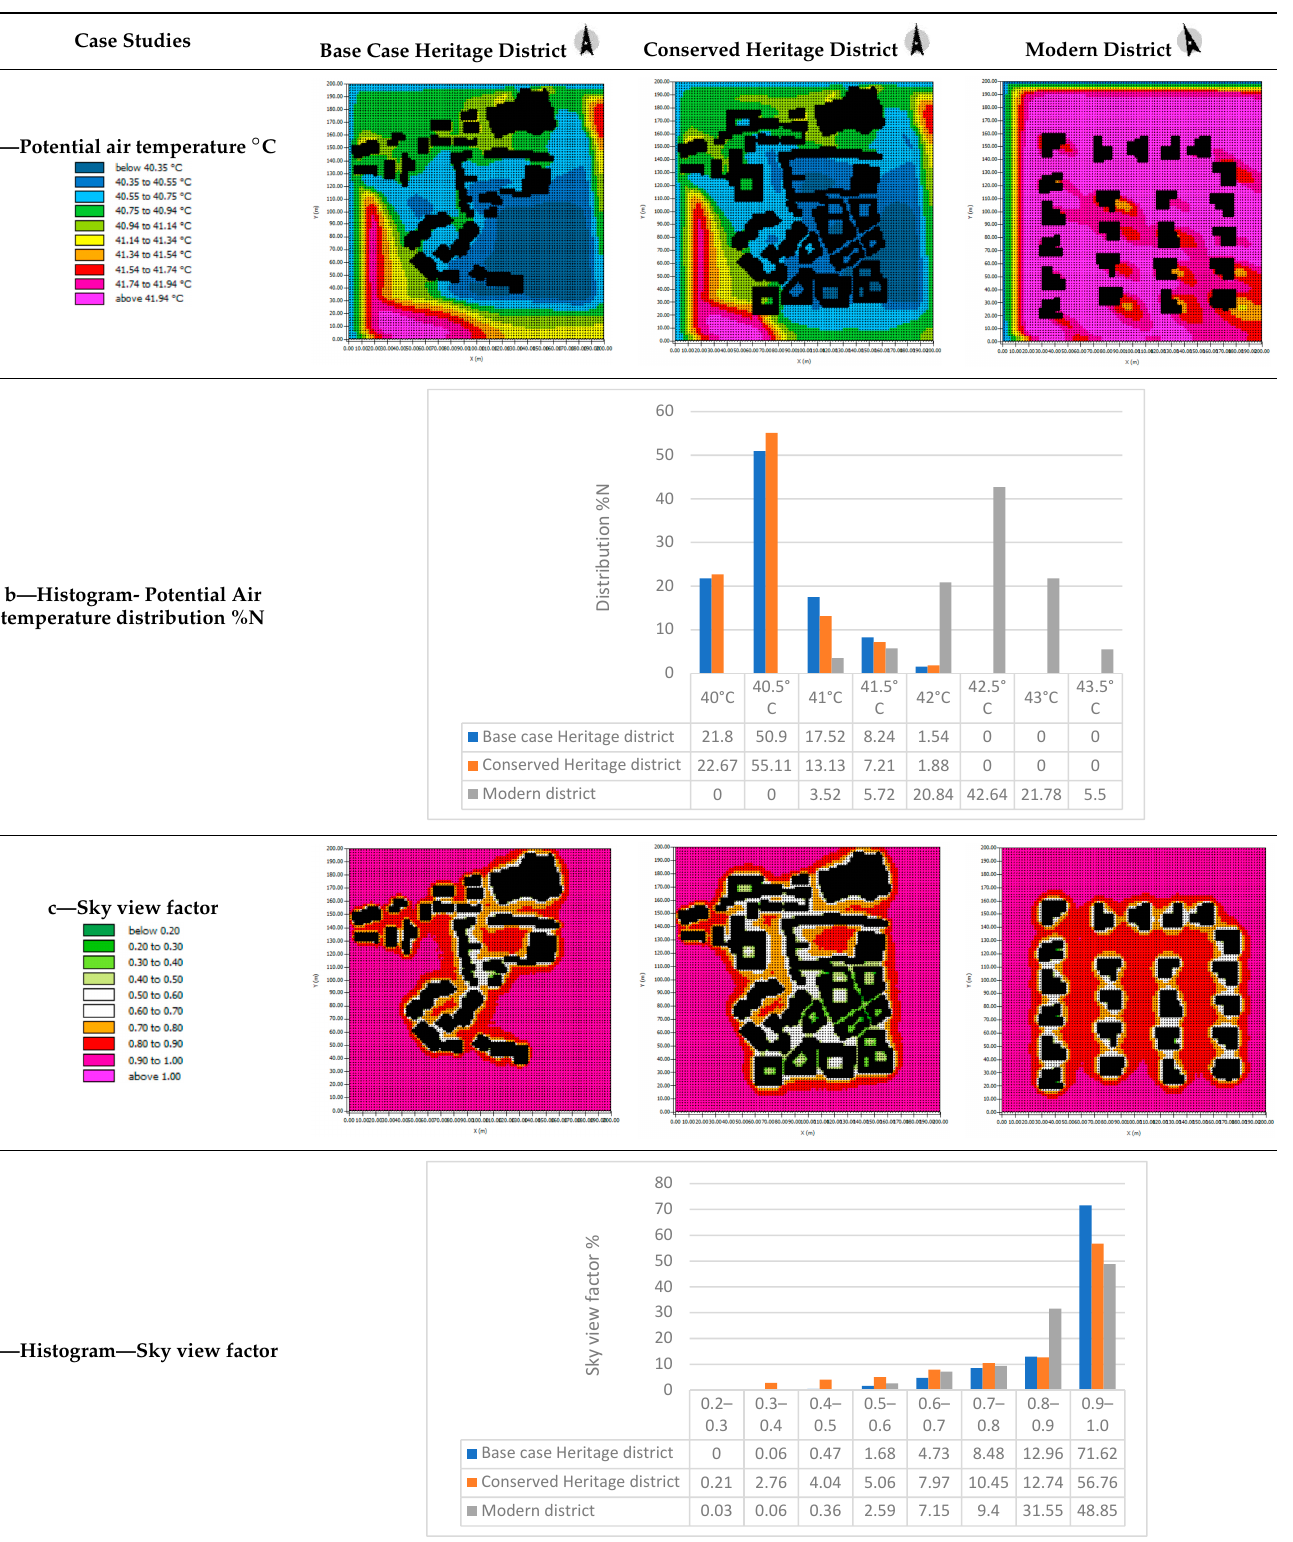
Table 6. Potential air temperature and sky view factor for the base case heritage, conserved heritage and the modern districts at 13:00 pm on 21st of August at a height of 1.8